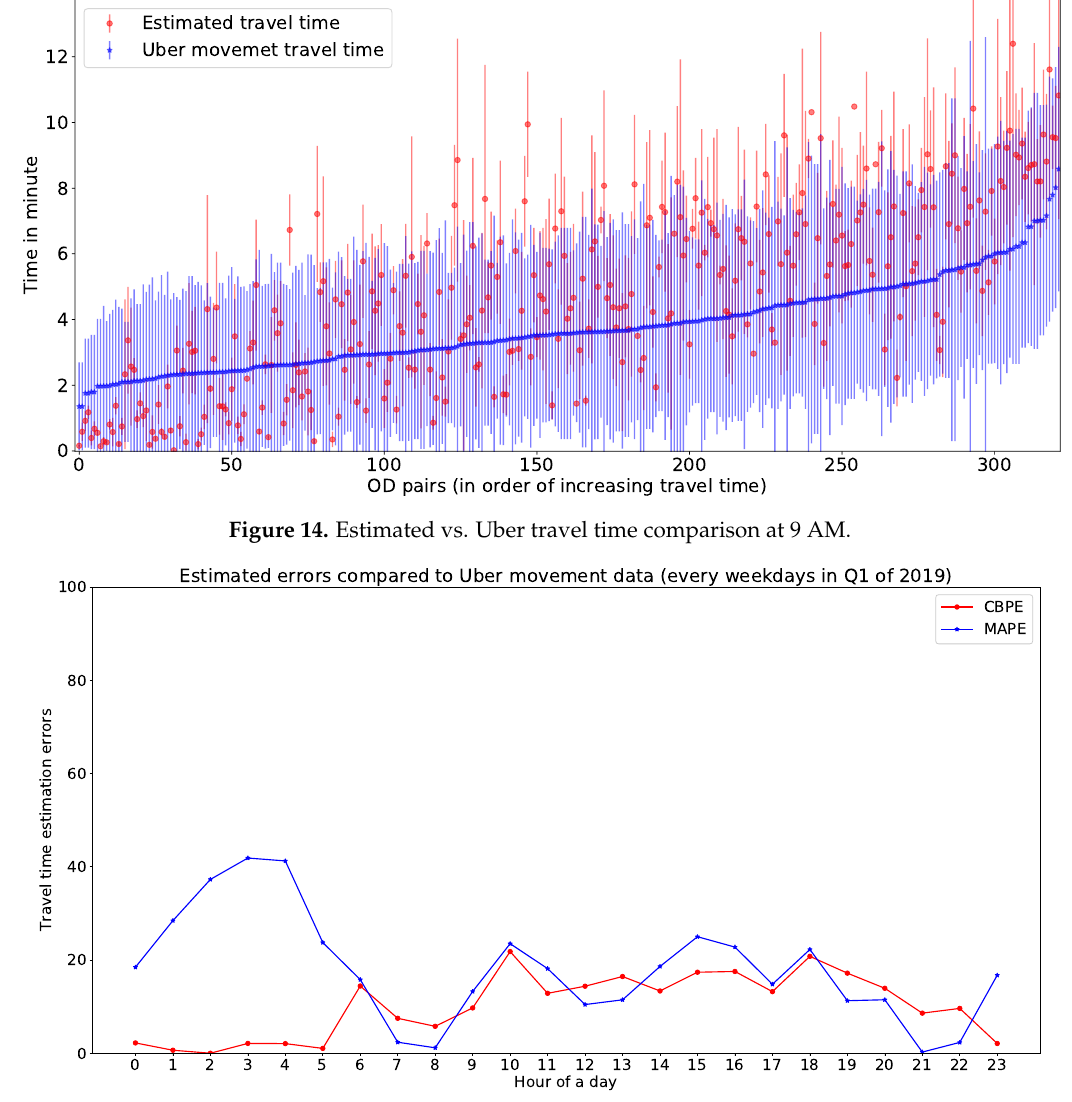
Figure 15. Different errors for the proposed model estimated travel time compared to Uber movement